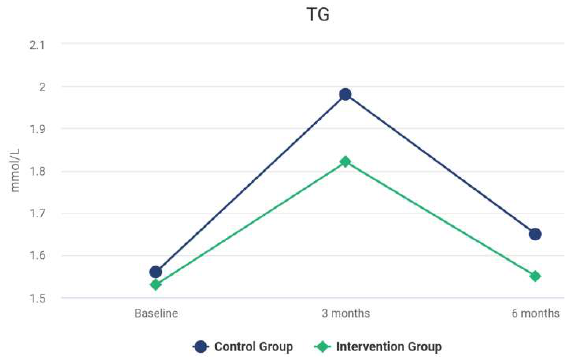
Figure 4. Results of TG at baseline and during follow-up.